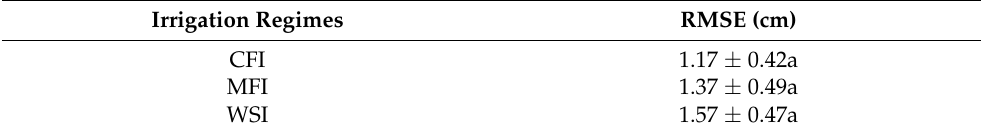
Figure 7. The actual field condition of water levels: ( a ) WSI-1; ( b ) WSI-2. RMSE values of the CFI regime showed the lowest level, indicating that the CFI plot was the best in controlling water level (Table 2). Its values were 1.17 cm, 15%, and 26% lower than that of MFI and WSI plots; however, the differences were not significant. The water level can generally be controlled as their values close to the setpoint, with RMSE below 1.6 cm. The biggest challenge in implementing the evapotranspirative irrigation was high rain intensity during one growing season. In hydrology, rainfall is always cor- related to the water level as many models have been developed [33,34]; thus, rainfall be- comes the most important factor in predicting water level under natural conditions. Table 2. The performances of evapotranspirative irrigation in each regime.